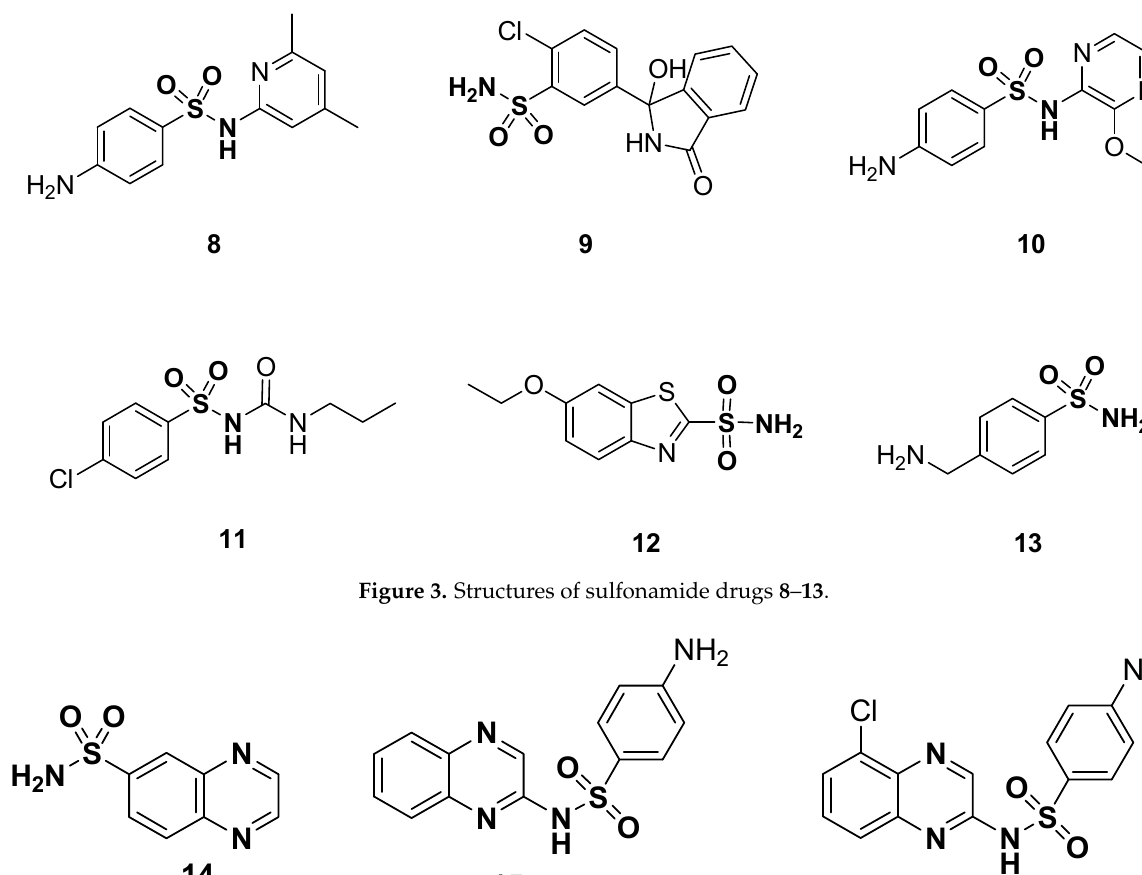
Figure 4. Structures of quinoxaline sulfonamide drugs 14–16.